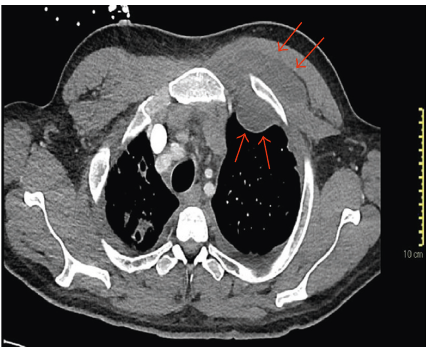
Figure 1: Multiple cavitary nodules within the right lung apex representing septic emboli. Bilateral pleural effusions with left-sided pleural-based focus of confluentfluid attenuation that extends through the anterior chest wall and insinuates between the pectoralis major and minor muscles representing empyema necessitans (arrows) are shown.